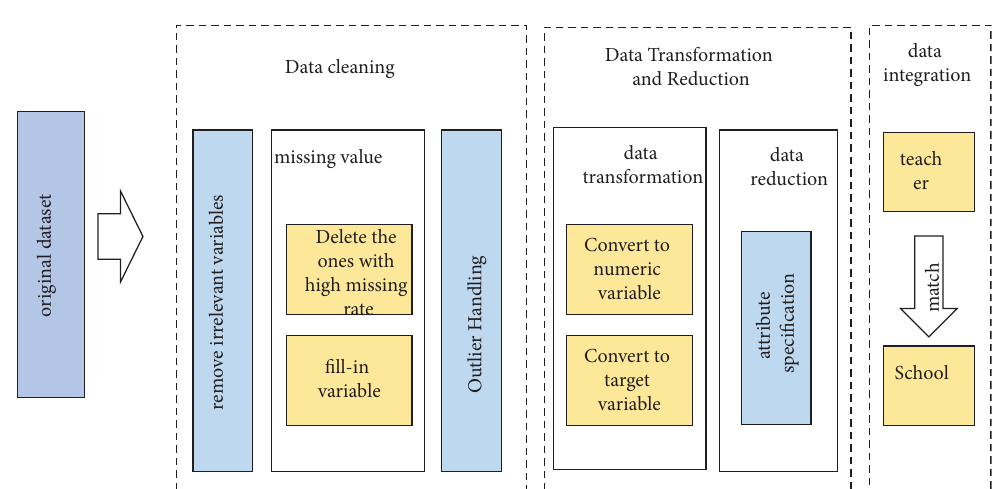
Figure 2: Data preprocessing process.